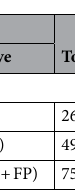
Table 3. COVsense testing method compared to the gold-standard